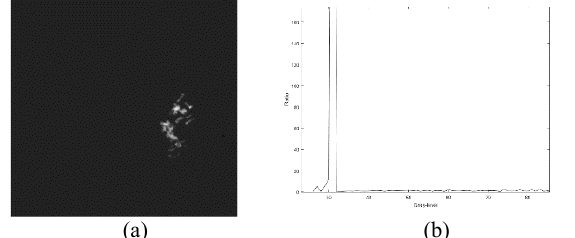
Figure 2. Multi-temporal images of Bern. (a) Image acquired on 20 April. (b) Image acquired on 25 May. (c) Ground-truth. From the curve about ratio value of adjacent GL shown in Figure 3(b), a steep peak is clearly shown on the left side of it, implying the backscatter enhanced regions are small.